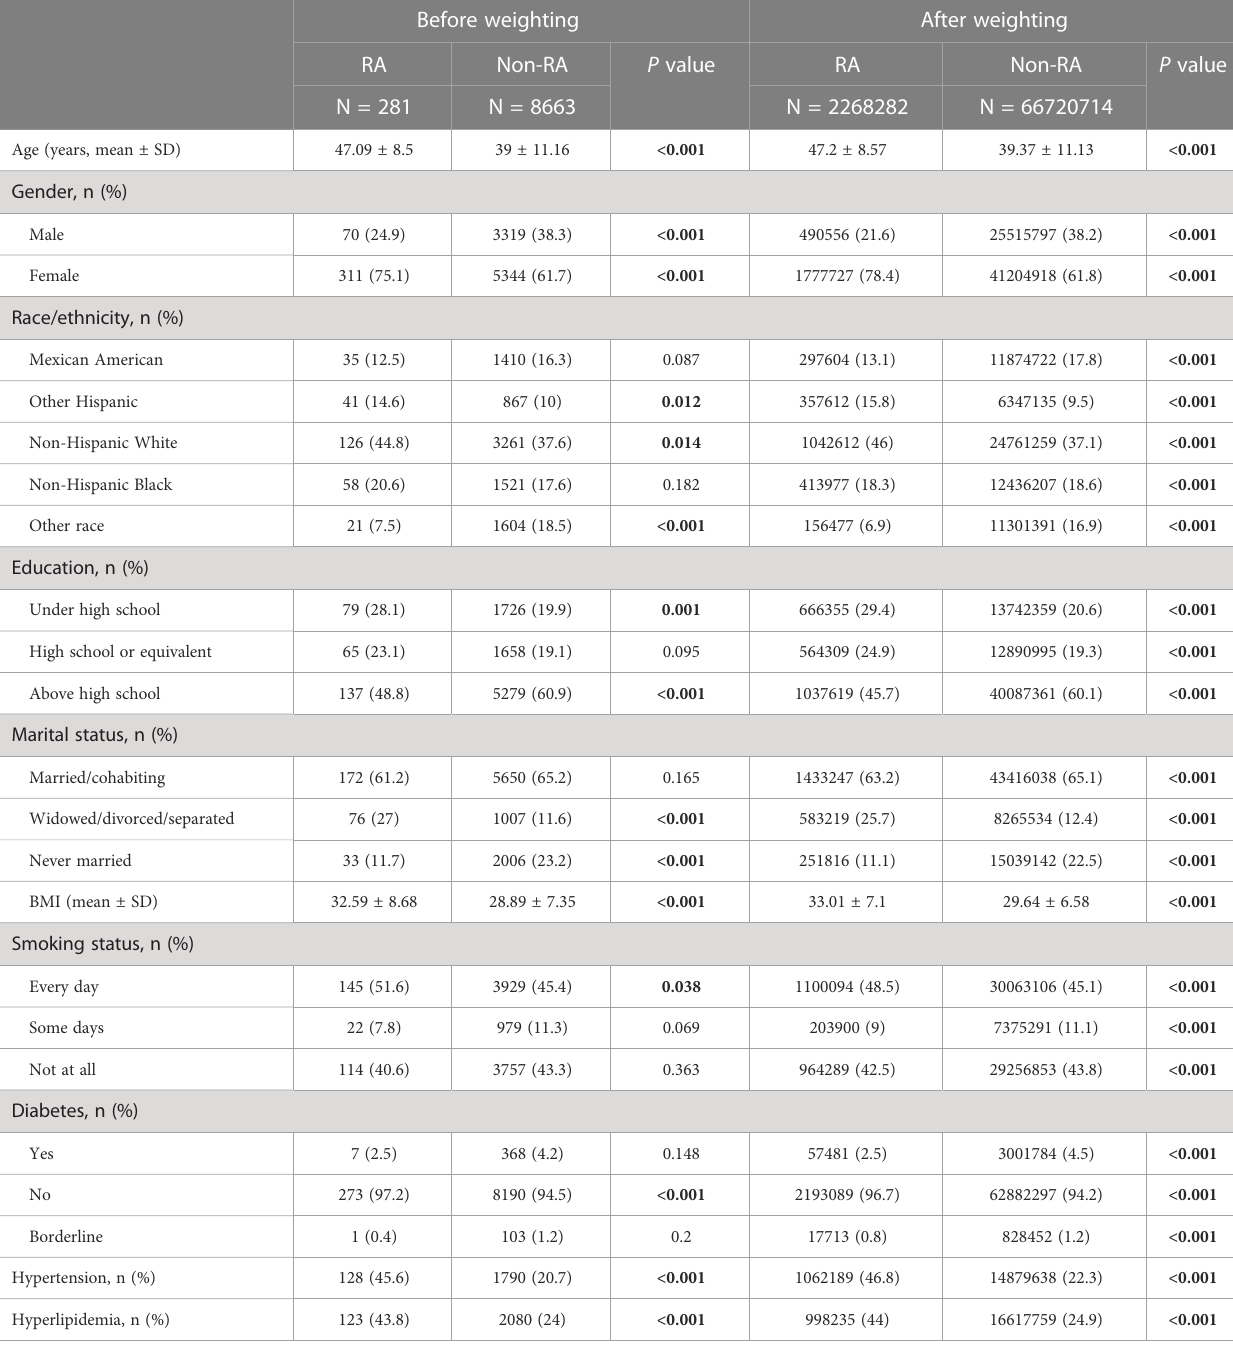
TABLE 4 Demographic characteristics of HPV immunization cohort before and after weighting, grouped by RA. Before weighting After weighting RA